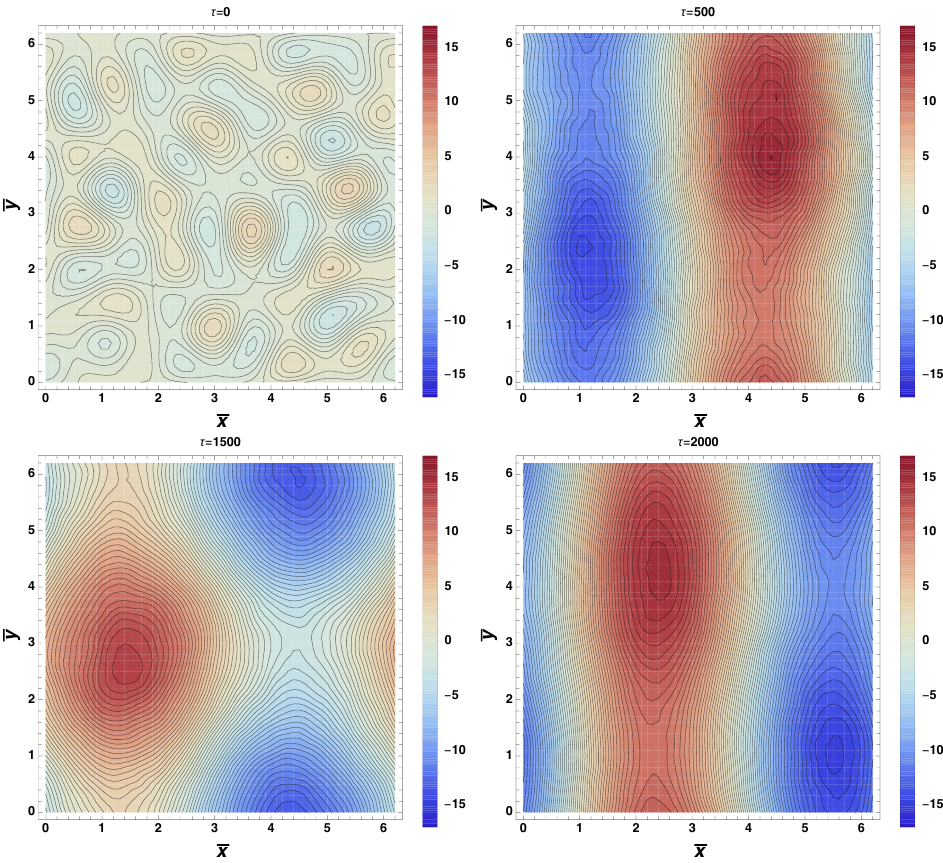
Figure 14. Case B—viscous. Contour plots of Φ ( ¯ x , ¯ y ) at fixed